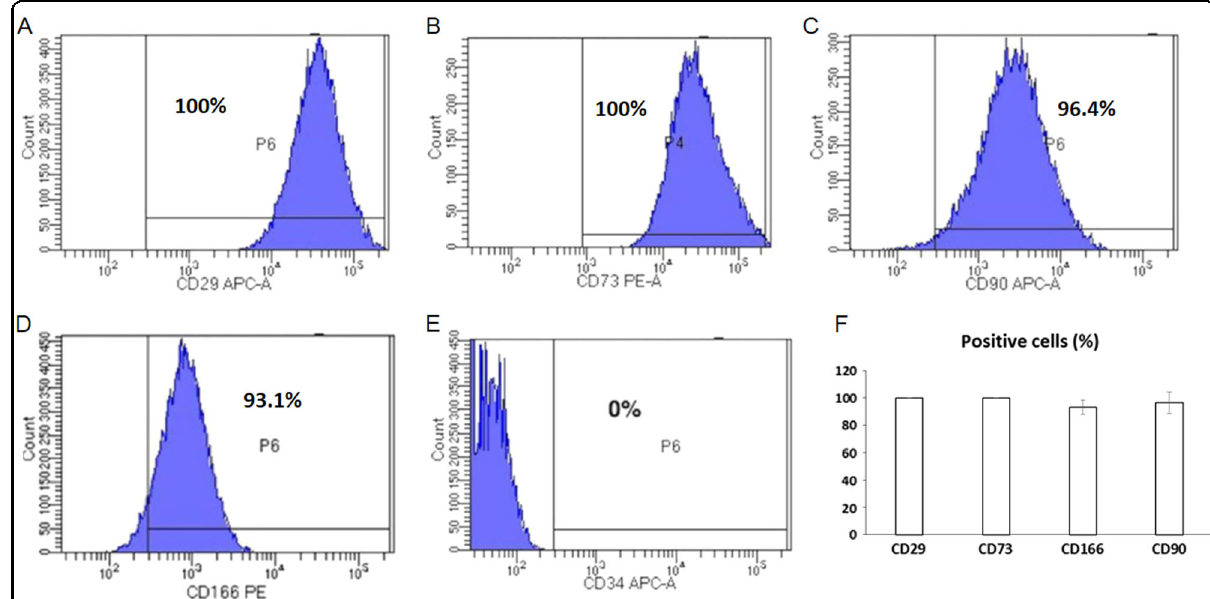
Fig. 1 Characterization of human PMSCs. a – e Representative fl ow cytometry histograms showing CD29, CD73, CD90 and CD166-positive PMSCs and CD34-negative PMSCs in passage 4 cultures, respectively. f Quanti fi ed percentage of CD29, CD73, CD90 and CD166-positive MSCs in passage 4 cultures. Data are the means ± SD of three independent